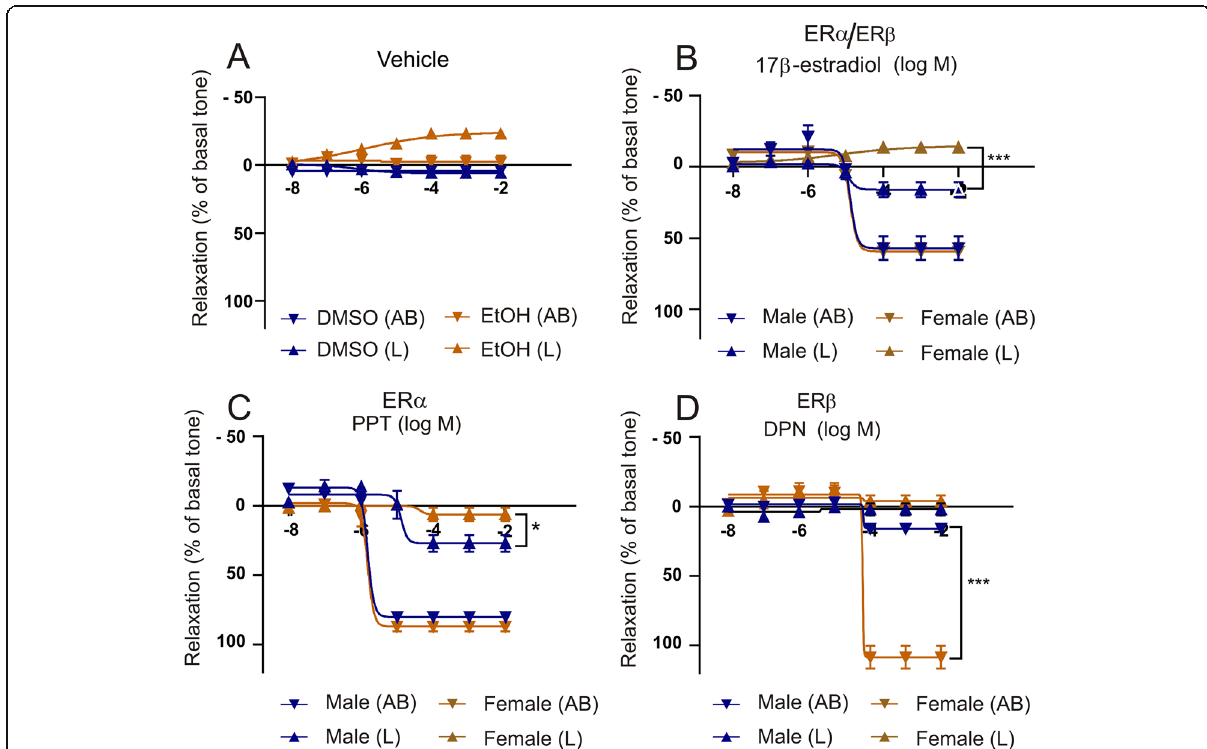
Fig. 12 Myograph response to ER α and ER β ligands on the male and female MCA. Isolated segments of rat middle cerebral artery (MCA), in the myograph. The data are shown as dilation from the myogenic tone. Cumulative concentration-response curves are shown for vehicle ( a ), 17 β - estrogen ( b ), PPT ( c ) or DPN ( d ) added luminally (L) or abluminally (AB). Data points represent means ± SEM. Significance was determined by two-way ANOVA, n = 6. * p < 0.05, ** p < 0.005, *** p <